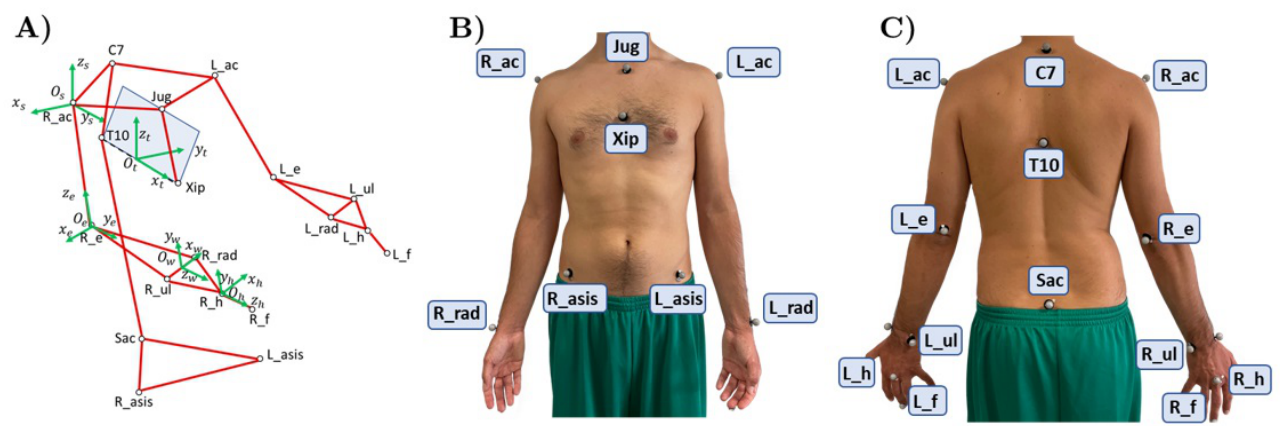
Figure 1. Modified Rab protocol adopted in this study. ( A ) Stick model showing the used protocol for markers positioning. The white dots highlight the marker positioning on the anatomical landmarks used for reconstructing the joint angles while the red lines represent segments connecting the joint centres. The blue plane represents the constructed sagittal plane of the participant. The green frames are used to measure joint rotations. The human model reported in this figure resembles the pose of the subjects at the beginning of each task. A complete list of the abbreviation is provided in Section Abbreviations . ( B , C ) show a participant equipped with the marker set.